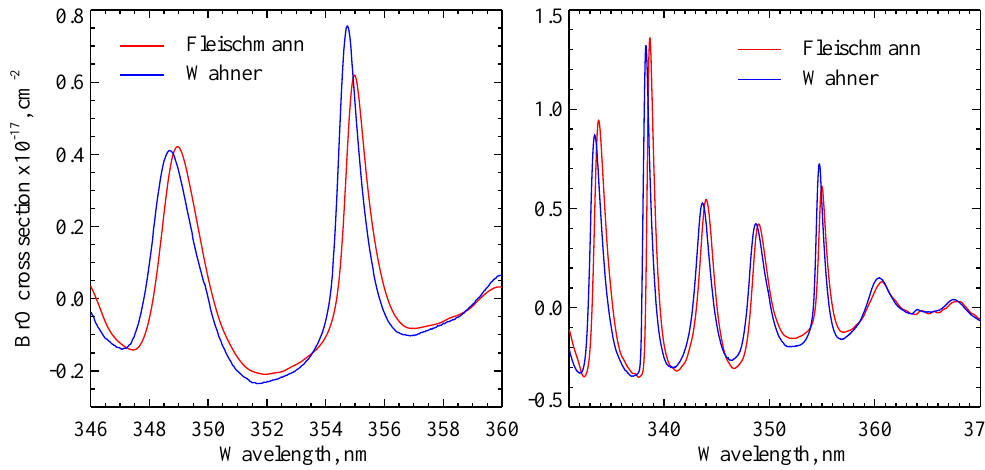
Fig. 14. BrO cross section at 223K according to Fleischmann et al. (2004) shown by the red curve and at 228K according to Wahner et al. (1988) shown by the blue curve. Left panel: 346–360nm spectral interval as used in the retrieval of the balloon-borne DOAS measurements. Right panel: 331–370nm spectral interval as used in the retrieval of the balloon-borne SAOZ measurements.